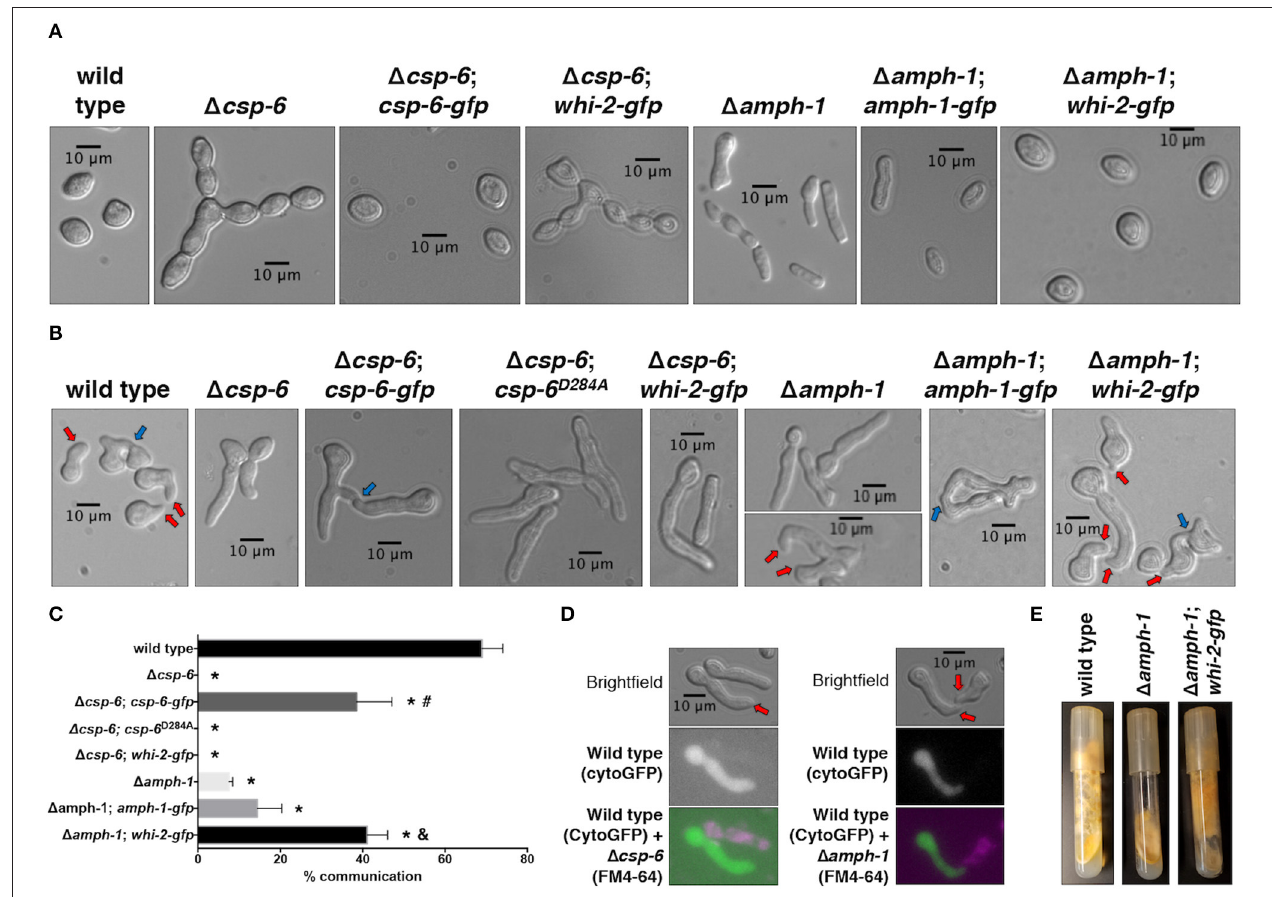
FIGURE 4 | The mis-expression of whi-2 in cells lacking amph-1 but not csp-6 compensates for germling communication and asexual defects. (A) Conidial morphology of indicated strains was analyzed by brightfield microscopy. (B) Cell-cell communication between cells from single strains (genetically identical) were evaluated between closely positioned germlings ( B , 4h post-inoculation). In (B) , red and blue arrows indicate conidial anastomosis tubes (CATs) and communication/fusion events, respectively. Note the presence of CATs in the 1 amph-1 strain (lower micrograph, red arrows). The relative frequency of cell-cell communication of strains shown in (B) is shown in (C) . Error bars represent the standard deviation.* p -value < 0.0001 vs. wild type; # p -value < 0.0001 vs. 1 csp-6 ; and, p -value < 0.0001 vs. 1 amph-1. (D) Cytoplasmic GFP-expressing wild type cells were mixed with FM4-64-stained 1 csp-6 or 1 amph-1 cells and observed by microscopy after germination. Note the formation of CATs (red arrows). (E) The production of aerial hyphae and sporulation was evaluated after 7 days of growth for the indicated